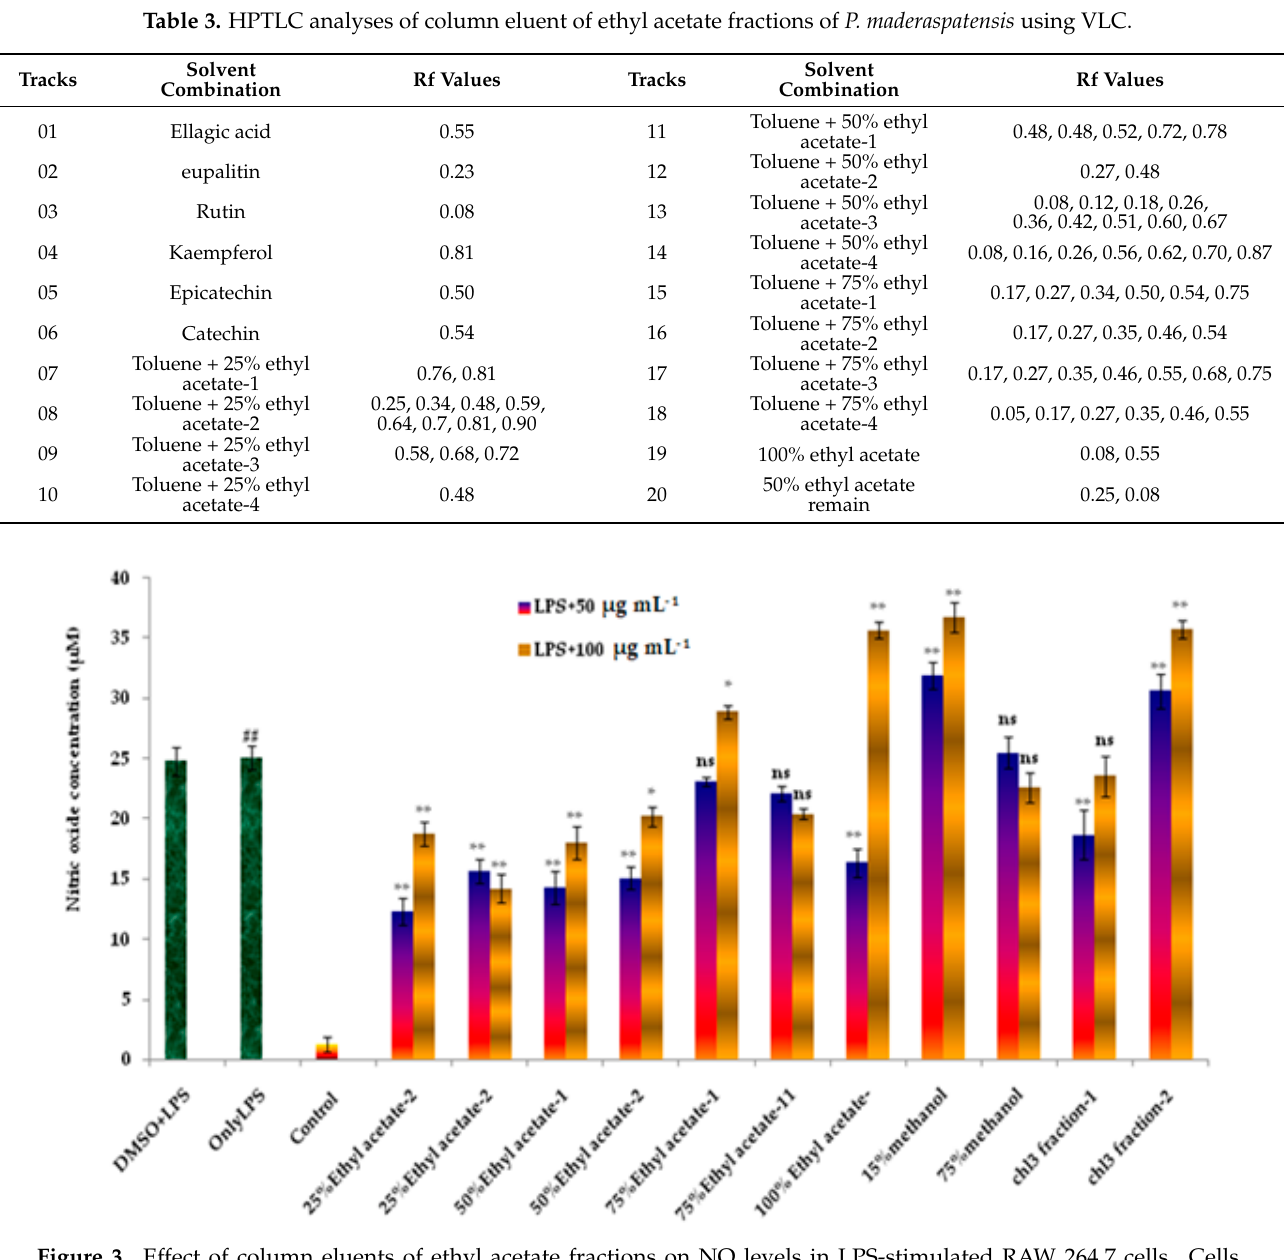
Figure 3. Effect of column eluents of ethyl acetate fractions on NO levels in LPS-stimulated RAW 264.7 cells. Cells (1 × 106 cells/well) in 96-well plates were first incubated with and without specified concentrations of column eluents for 2 h, and then incubated with LPS (10 µ g/mL) for 20 h. ## LPS treated. Untreated is the negative control without LPS treatments. Values are expressed as mean ± SEM. ns: non-significant, n = 3, data ± S.E.M. Groups 3–7 were compared against group II using Dunnett’s post-hoc test (* significant at < 0.01; ** significant at < 0.001).